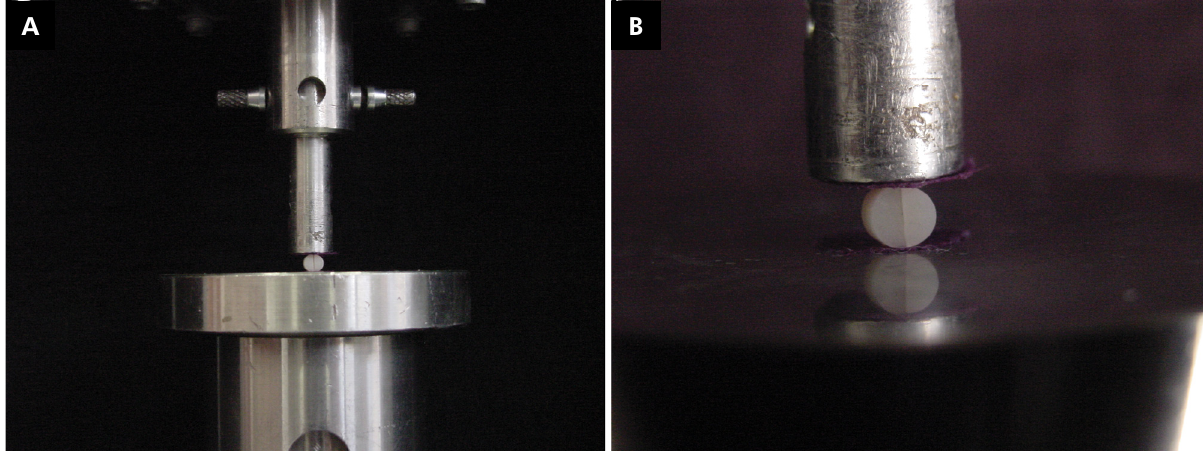
Figure 5. Diametral tensile strength test (a) and specimen after fracture, in detail (b)